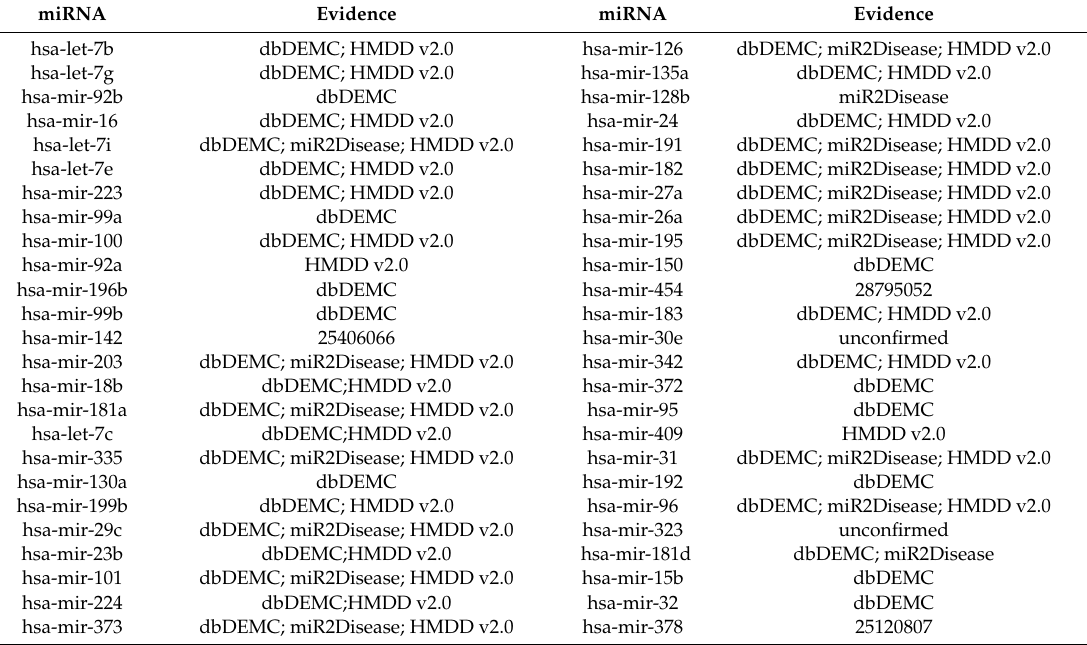
Table 3. Prediction of the top 50 potential BN-related